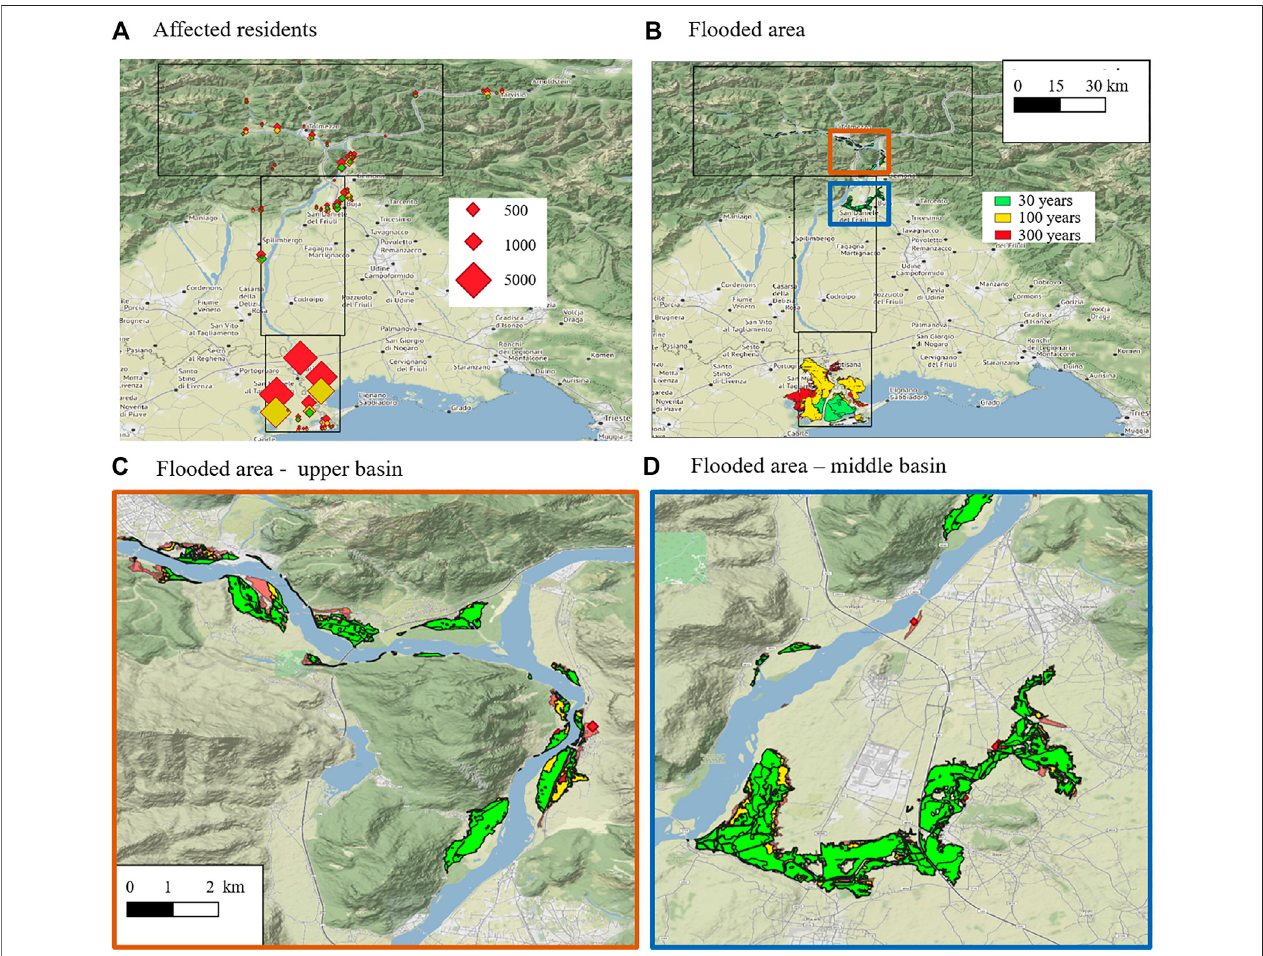
FIGURE4|(A) PGRAmapofaffectedresidentsintheareasatriskforthethreereturnperiodsconsidered:30 years(green),100 years(yellow)and300 years(red). The symbol size is proportional to the number of affected residents. The black outlines correspond to the areas used in the risk mapping question (Q2). (B) PGRA fl ood areamap forthe same threereturn periods.Areas fl ooded byhigher returnperiod eventsinclude areas fl ooded bylowerreturnperiod fl oods,e.g., areas fi lledwithgreen would be fl ooded also by higher return period, red or yellow, fl oods. (C) Detailed upper basin fl ood areas corresponding to the three return periods. (D) Detailed middle basin fl ood areas corresponding to the three return